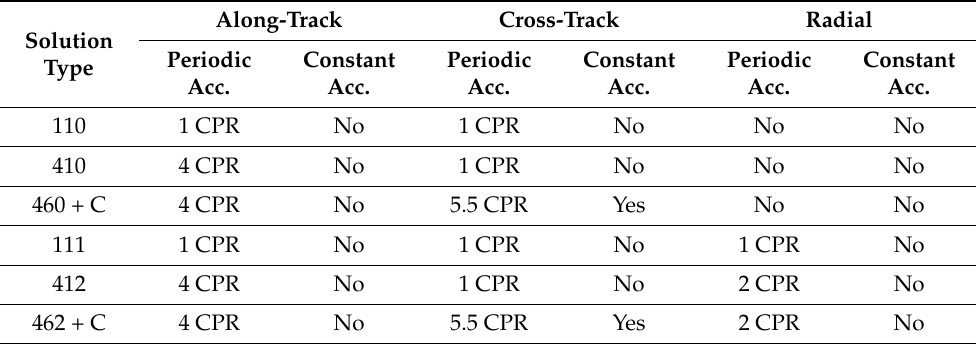
Table 2. Three-digit codes for different PEA solutions in POD. The number represents the frequency of periodic acceleration, and the letter ‘C’ represents the addition of constant acceleration in the cross-track